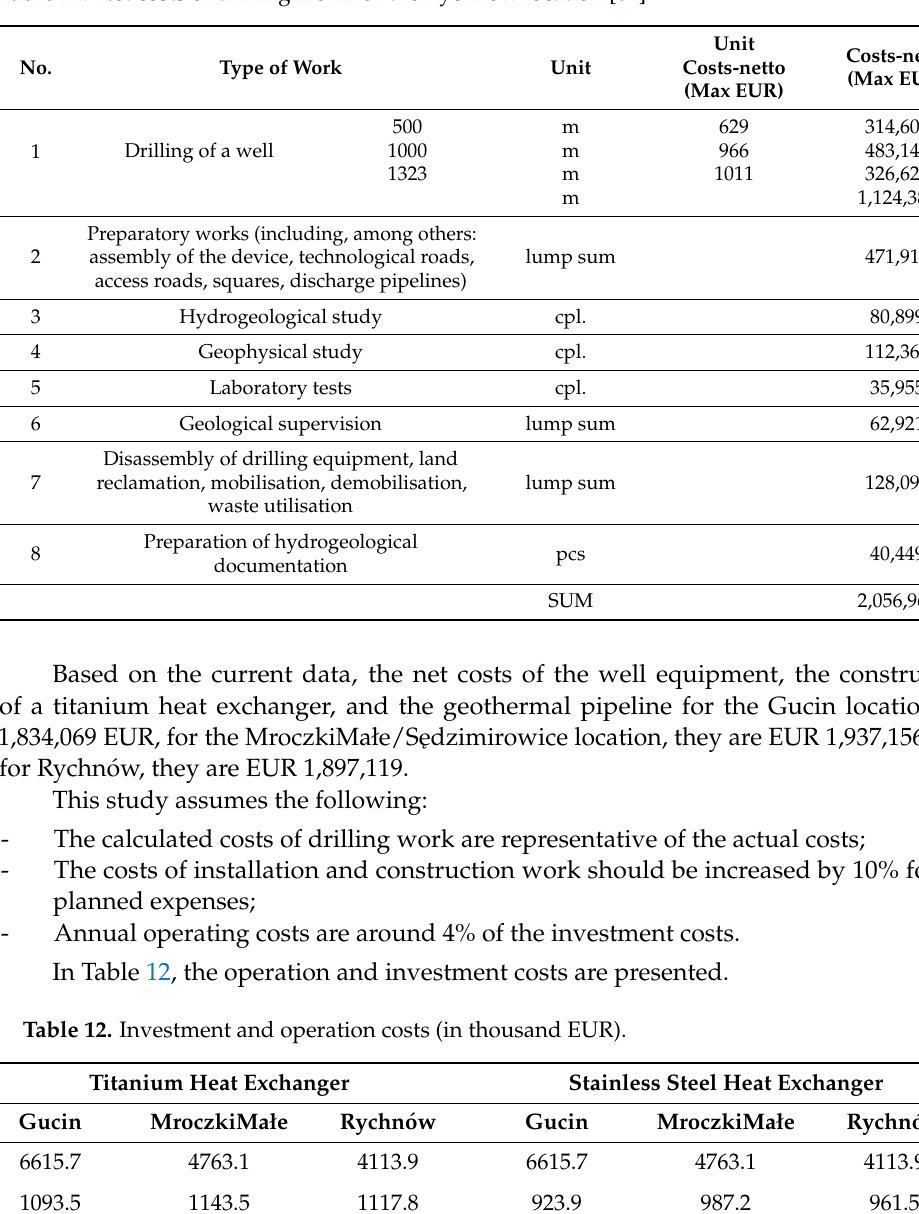
Table 11. Net costs of drilling work for the Rychn ó w location [64].